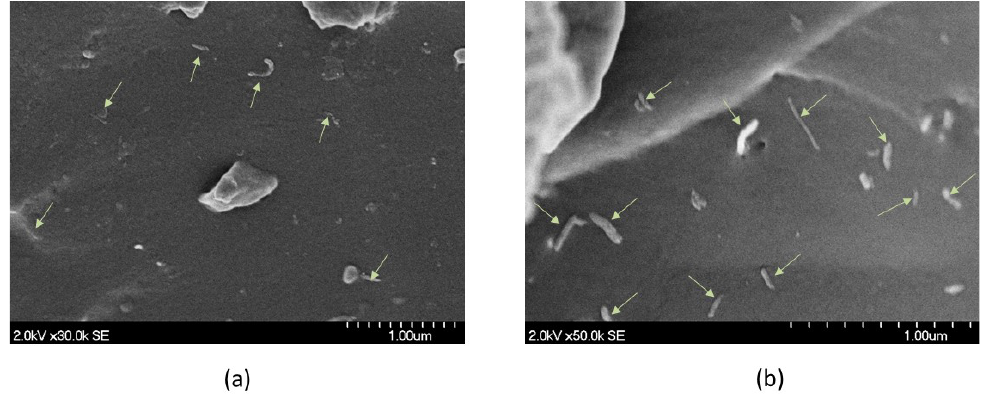
Figure 9. SEM images showing dispersion of ( a ) 0.5 wt% MWCNTs; ( b ) 1.0 wt% MWCNTs in